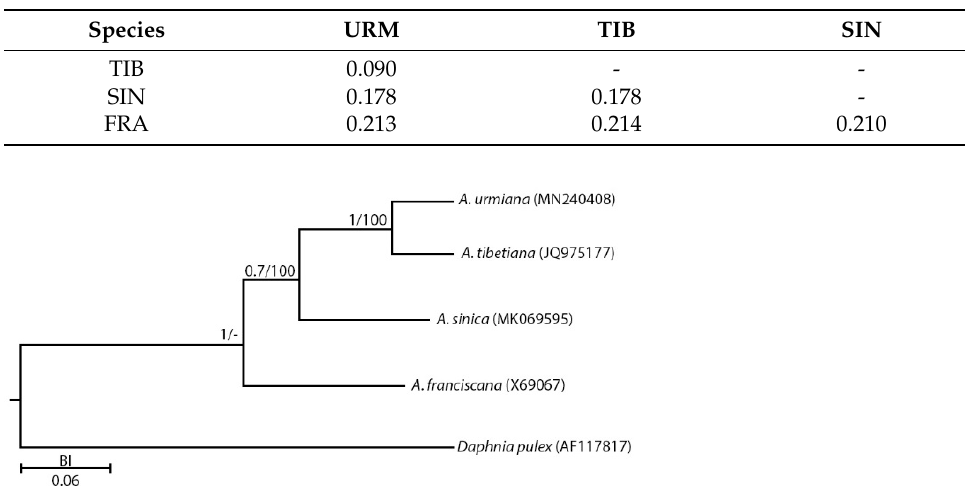
Table 2. Pairwise genetic distances using constructed using PCG+rRNA genes (URM: A. urmiana , TIB: TIB: A. tibetiana , SIN: A. sinica , FRA: A. franciscana ). A. tibetiana , SIN: A. sinica , FRA: A. franciscana ).